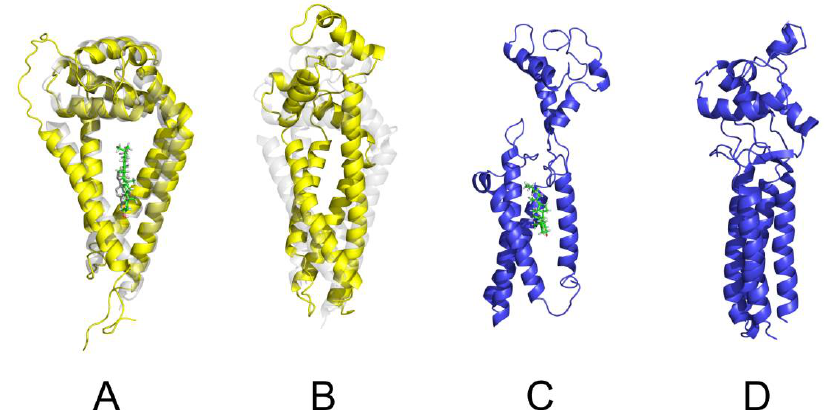
Figure 8. Models of CD81 and CD9 with and without cholesterol. ( A ) CD81 monomer (yellow) with bound cholesterol (green) after 50 ns MD simulation, showing the conical shape of the TM helices. Overlaid is the starting crystal structure (transparent gray); ( B ) CD81 monomer (yellow) without cholesterol after 50 ns MD simulation. The TM helices adopt more compact cylinder like conformation; ( C ) CD9 monomer (blue) binding cholesterol (green) after 50 ns MD simulation. The model suggests that contrary to the CD81 case the extracellular domain is more extended in cholesterol rich environment; ( D ) CD9 monomer (blue) without cholesterol after 50 ns MD simulation showing a tight interaction of the TM helices.